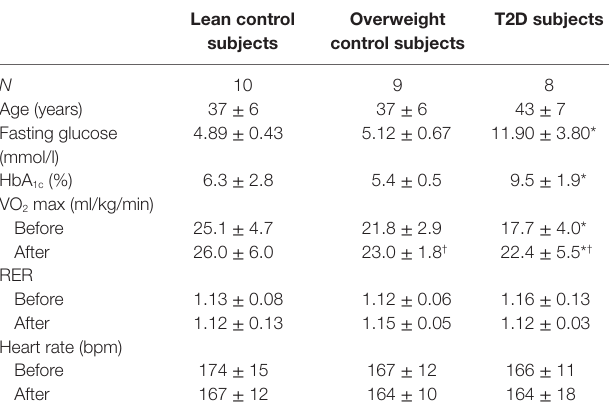
TAble 1 | Decreased exercise capacity in type 2 diabetes (T2D)—exercise training